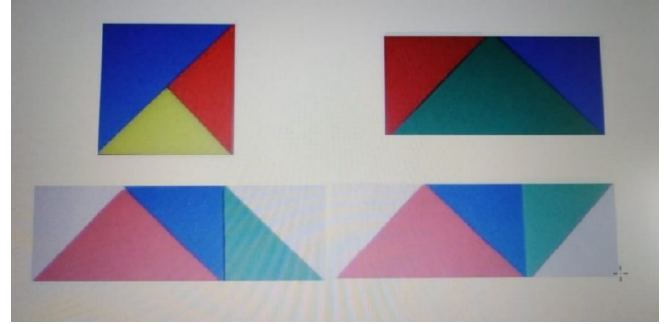
Figure 15. Quadrilaterals. Figure 15.